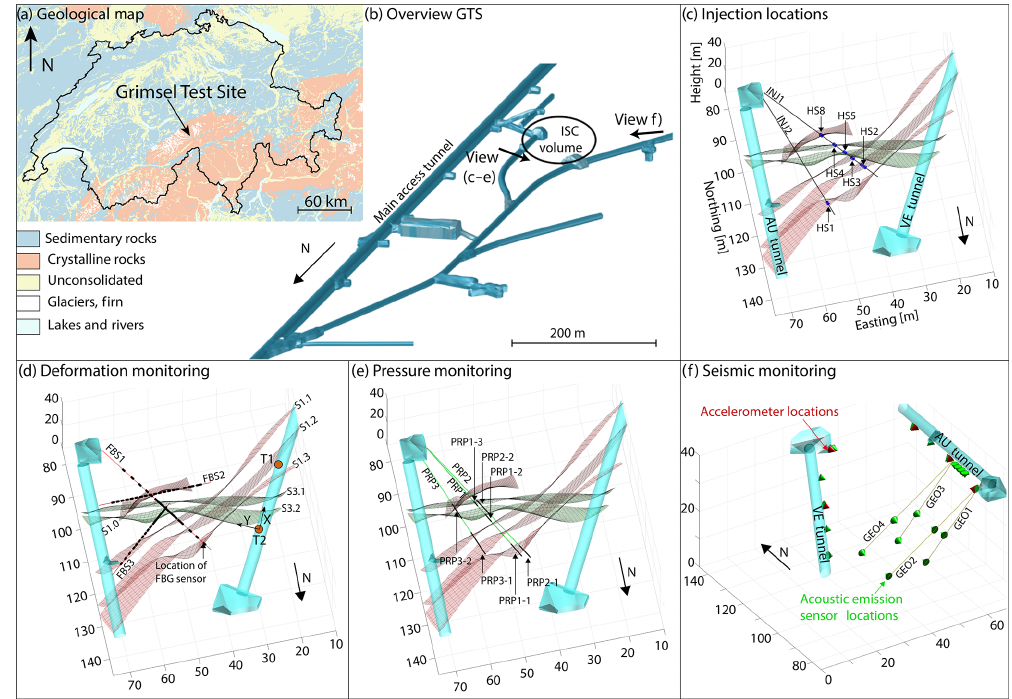
Figure 1. Location of the GTS in Switzerland indicated in the geological map (a) and the location of the test volume within the GTS (b) . Panel (c) shows the location of the injection intervals together with the target shear zones. Panel (d) illustrates locations of the strain sensors and tiltmeters, with indicated tilt axes, and labels the target shear zones. The pressure monitoring intervals are shown in (e) , and the station locations of the seismic monitoring network are indicated in (f) . More details on the monitoring setup can be found in Doetsch at al.